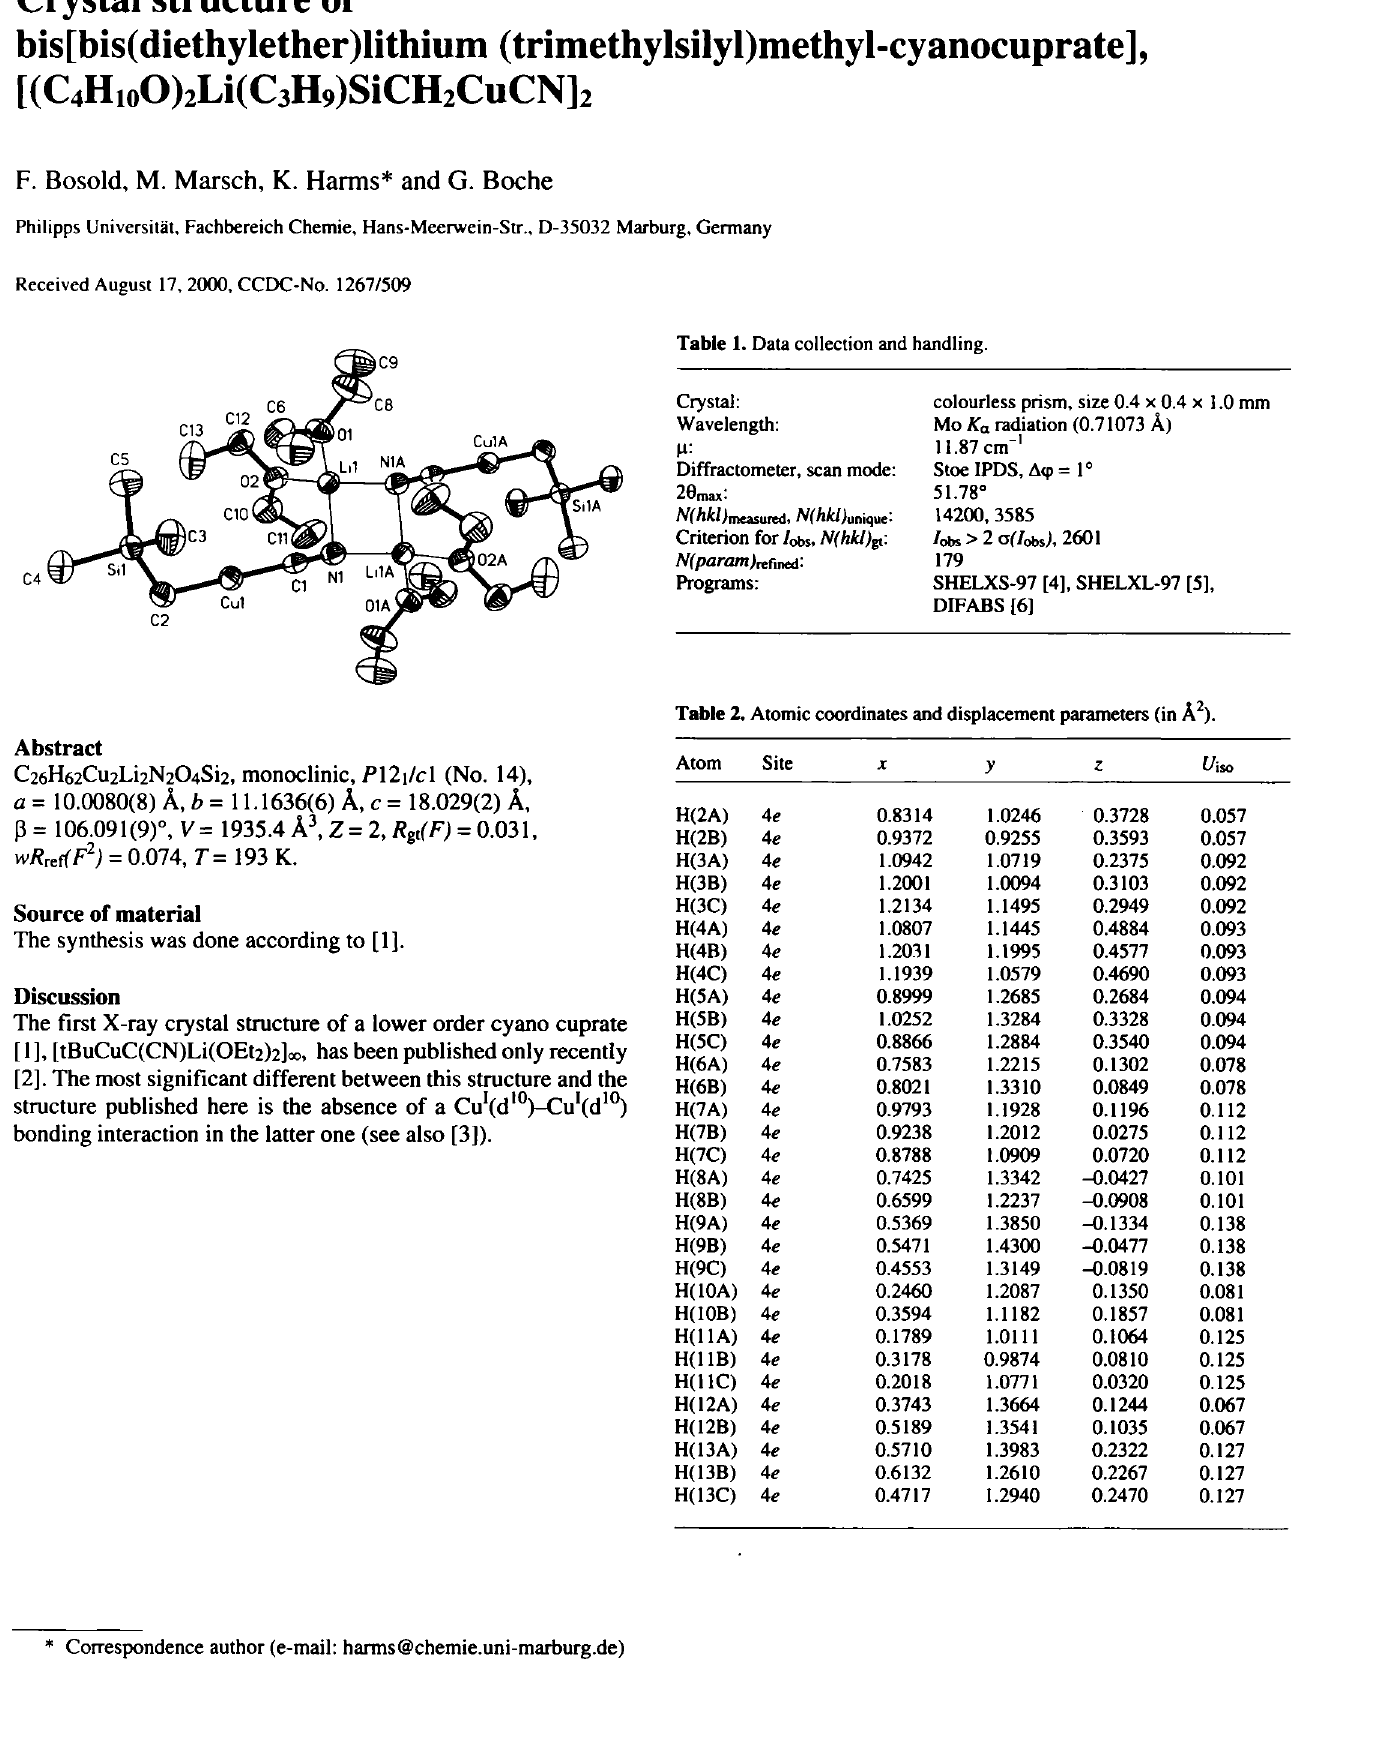
Table 1. Data collection and handling.